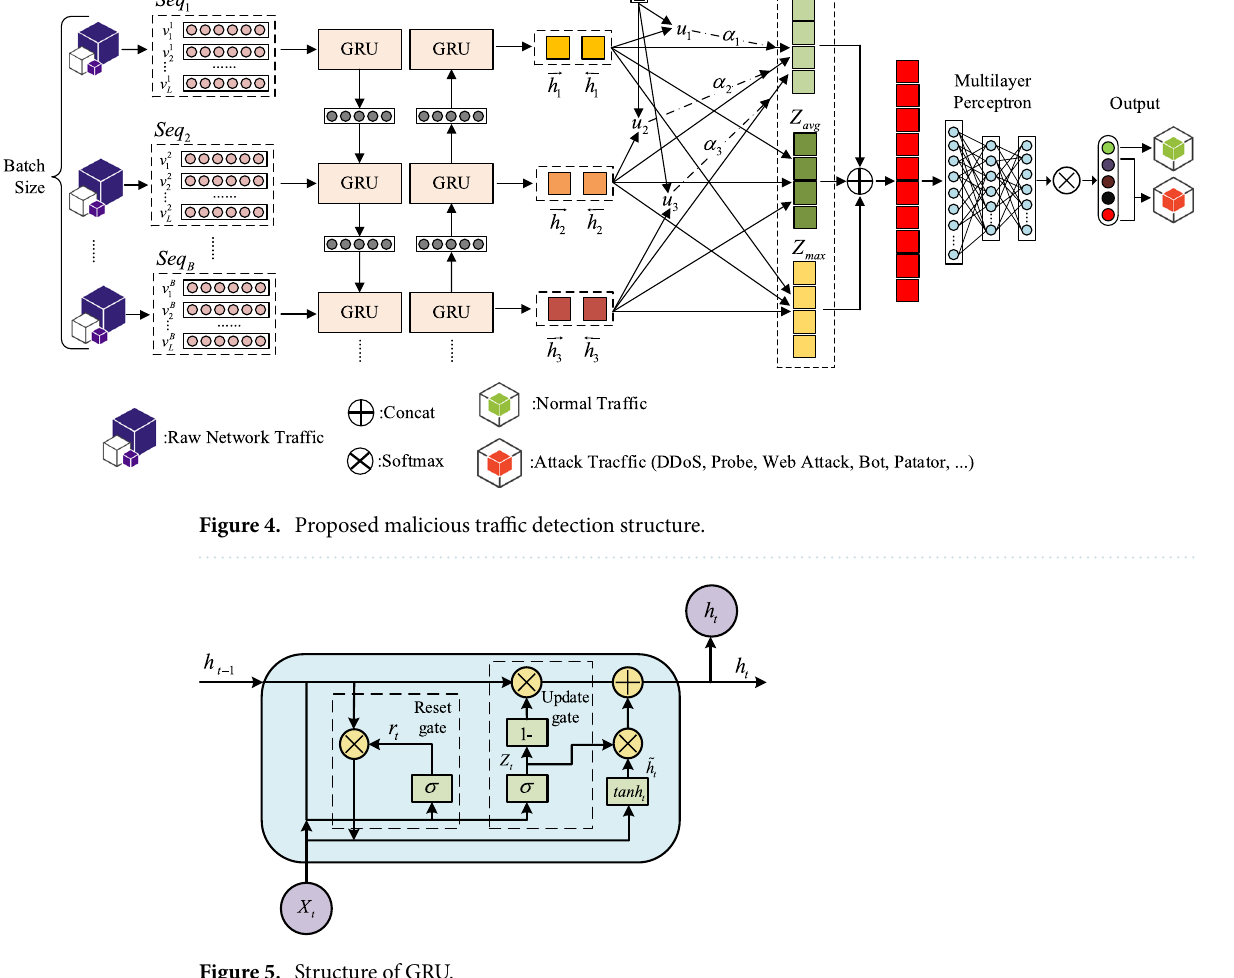
Figure 5. Structure of